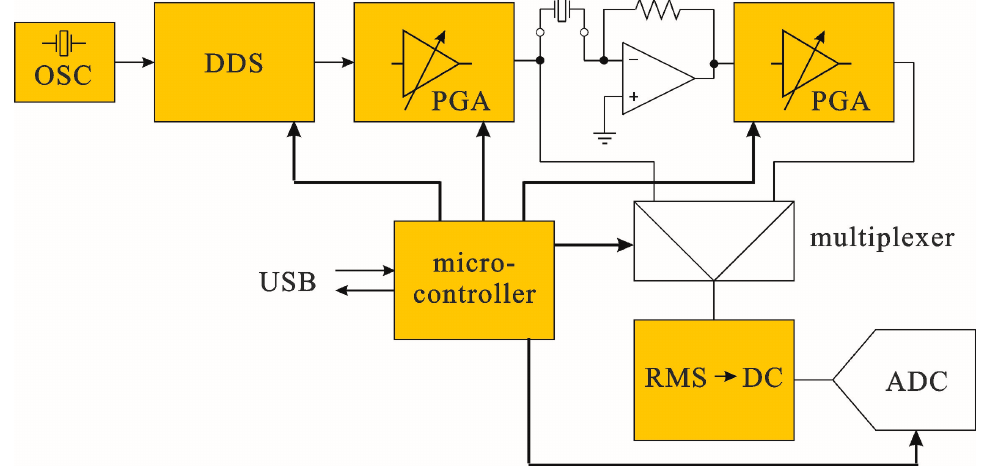
Figure 4. Block diagram of a system used for QTF characterization.